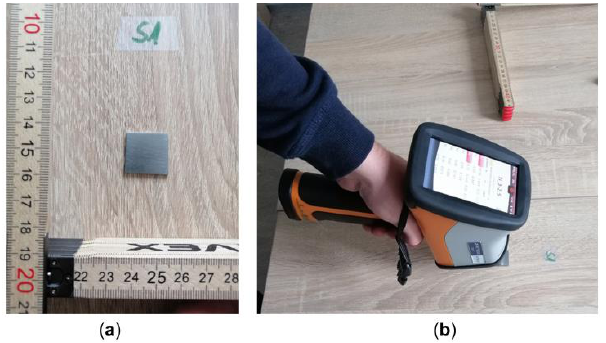
Figure 11. Examination of the steel chemical composition with an X-ray analyzer: ( a ) sample; ( b ) X-ray analyzer X-MET8000 Expert-Hitachi. Table 1. Results of determining of the steel chemical composition.